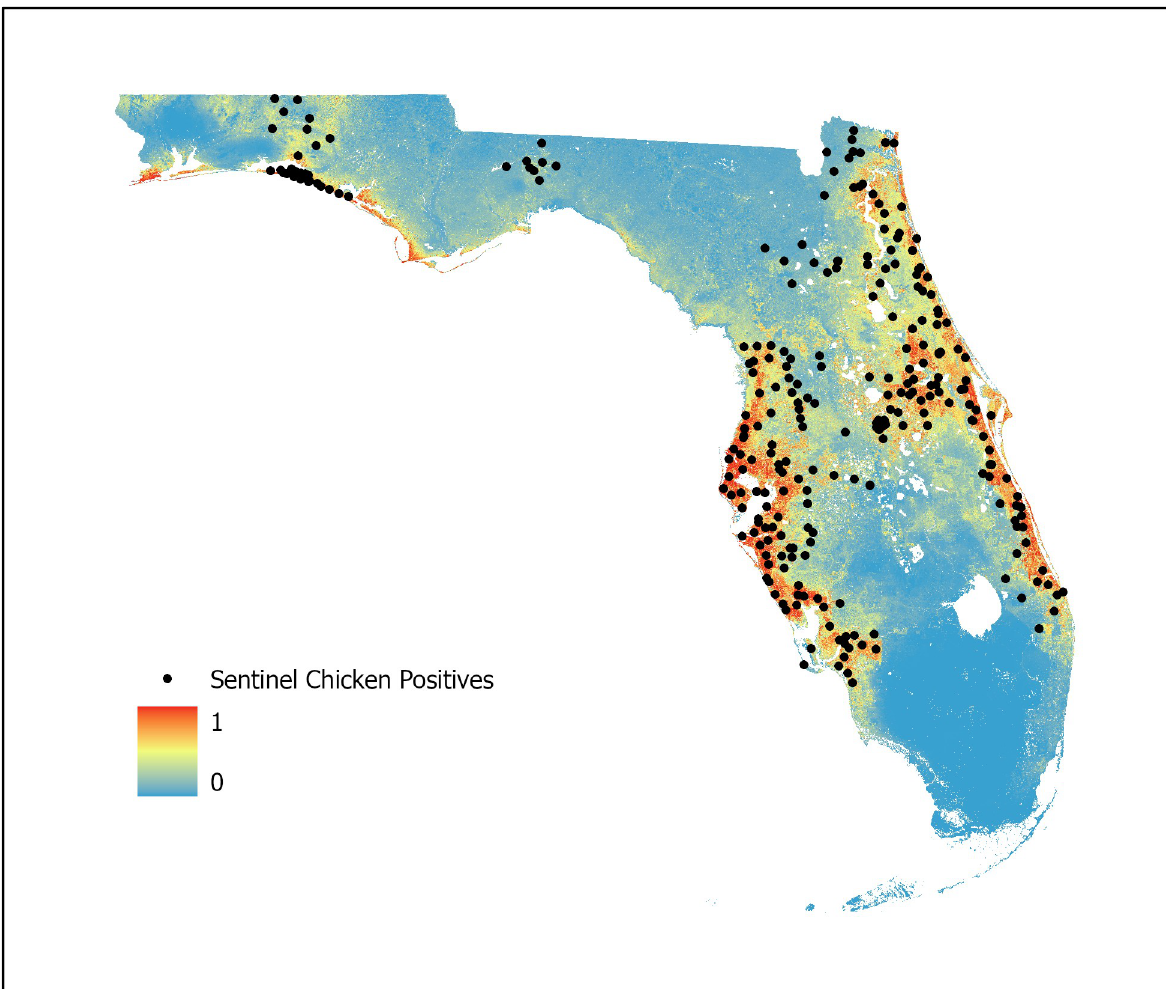
Fig 3. Preliminary model. Preliminary modeling using the complete presence dataset and all available land cover and environmental variables. Model overfitting occurred with selection of developed regions to the exclusion of others.